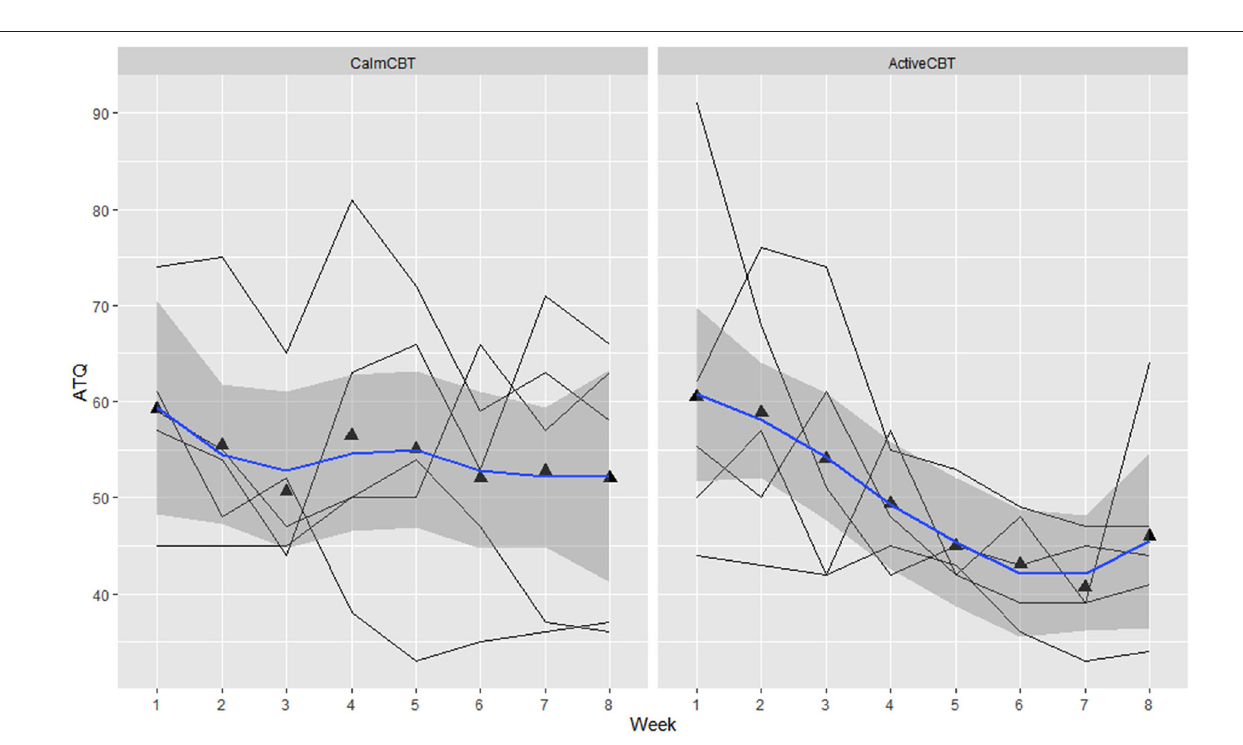
Frontiers in Psychiatry | www.frontiersin.org 12 May 2022 | Volume 13 | Article